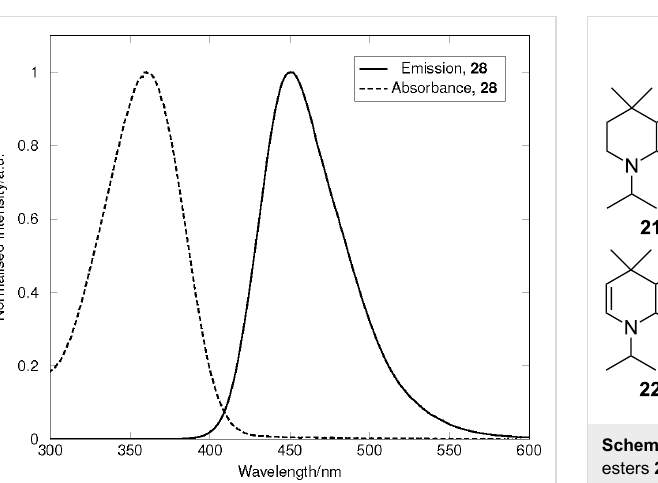
Figure 3: Combined, normalised absorption and emission spectra of 28 in chloroform. Absorption spectrum was recorded at 10 μ M. Emis- sion spectrum was recorded at 100 nM, with excitation at 360 nm.